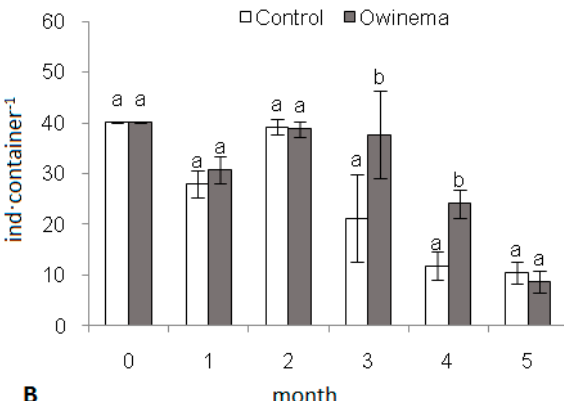
Figure 2. Mean number of E. fetida individuals (ind ∙ container − 1 ± SD) in experimental ecological boxes depending on the presence of an Owinema bio-preparation (50 mln larvae m − 2 ) during a 5 month experiment: ( A ) mature, ( B ) immature (a, b indicate significant differences between two means).